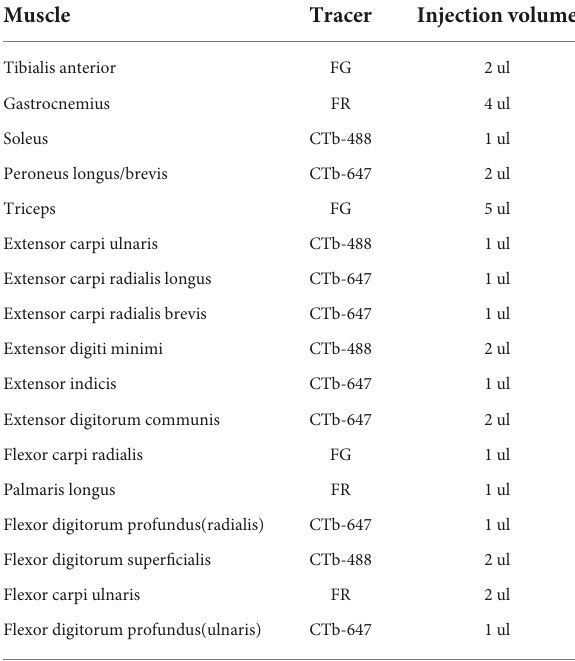
TABLE 2 The retrograde tracers and injection volume of muscles. Muscle